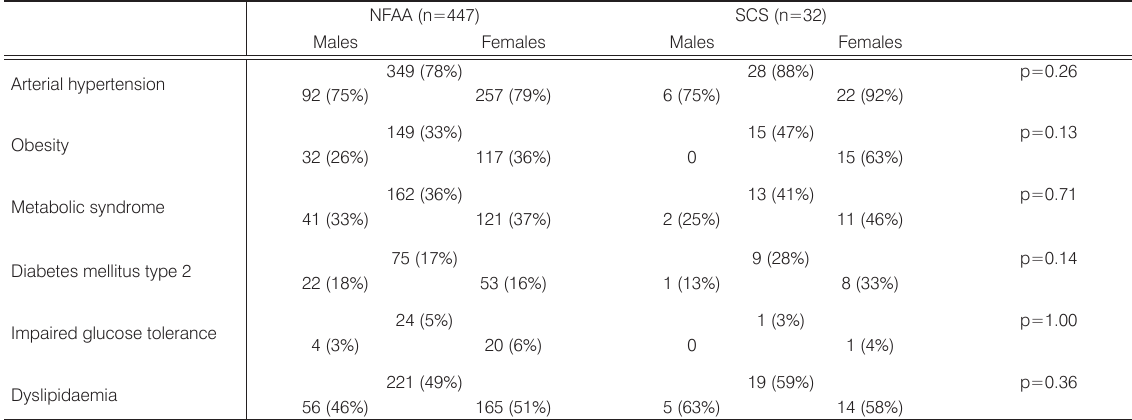
served for the rates of obesity, diabetes, IGT, metabolic